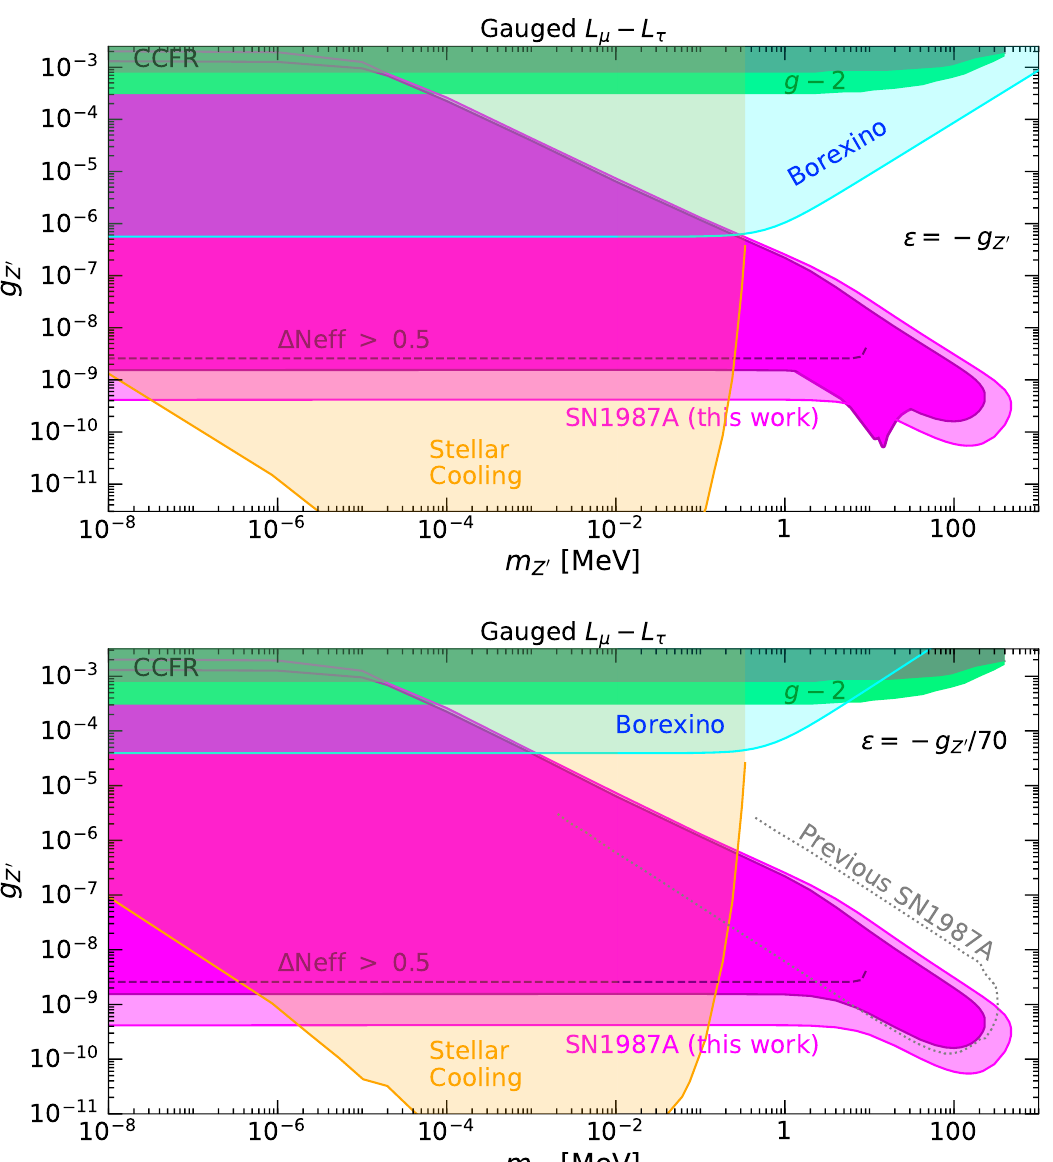
Figure 4. Parameter space for L µ − L τ gauge bosons, where there is additional kinetic mixing present. Top panel has set (cid:15) = − g Z 0 , bottom panel has set (cid:15) = − g Z 0 / 70 , which is considered a “nat- ural” amount of mixing for the L µ − L τ scenario. New SN1987A limit is shown as magenta shaded re- gion. Darker region is the conservative calculation, lighter outer region is less conservative (see